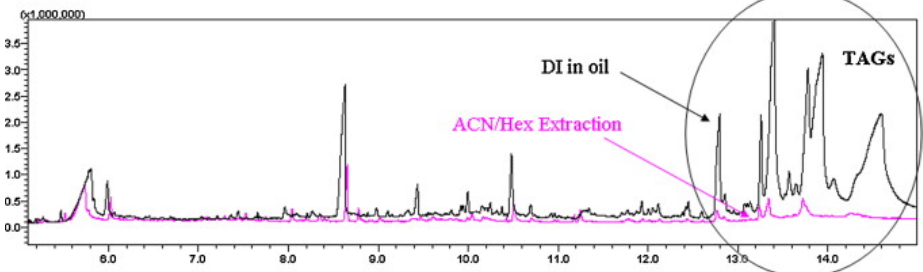
Figure 4. Comparison between the total ion chromatograms (TIC) obtained by direct immersion (DI) of the fiber in the oil/hexane solution, as reported by Purcaro and co-workers [95], and by the DI in hexane after ACN extraction of the oil sample as described in the text [85].